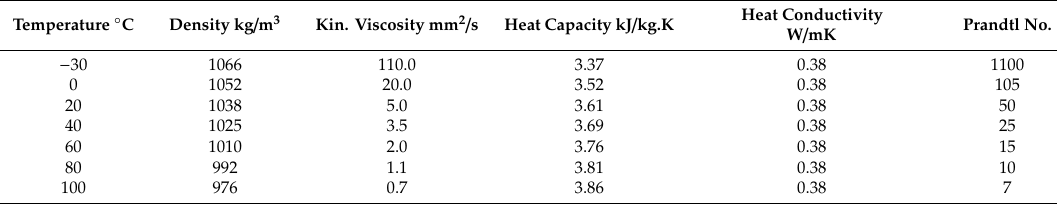
Table 2. Parameters of heat-transfer fluid in temperature modes − 30 ◦ C to 100 ◦